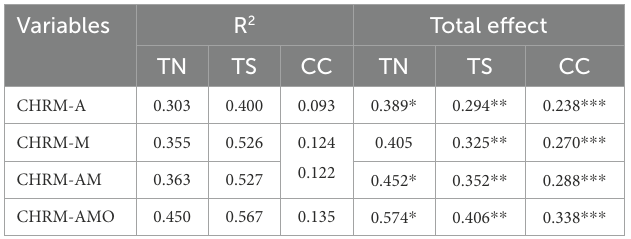
TABLE 7 Comparison of indirect effects between different dimensions in